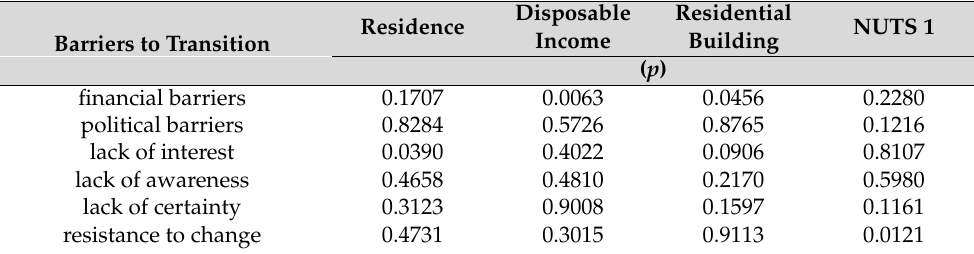
Table 11. Evaluation of barriers to energy transition according to variables characterizing the study sample (Results of Kruskal–Wallis ANOVA and Mann–Whitney U test).